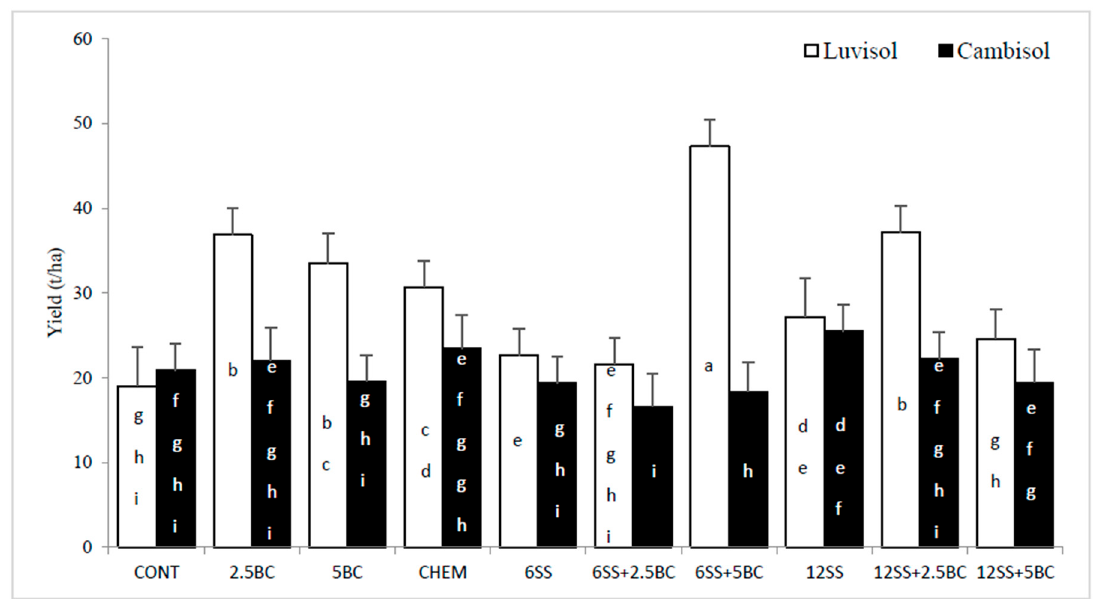
Figure 3. Spinach yields in contrasting soils as affected by treatments. For each variable, columns for both soil types with different letters are significantly different ( p < 0.05) according to Duncan’s multiple range test. Comparison of treatment means for both soil types indicate the statistics were done simultaneously. Error bars denote standard error ( n = 3).